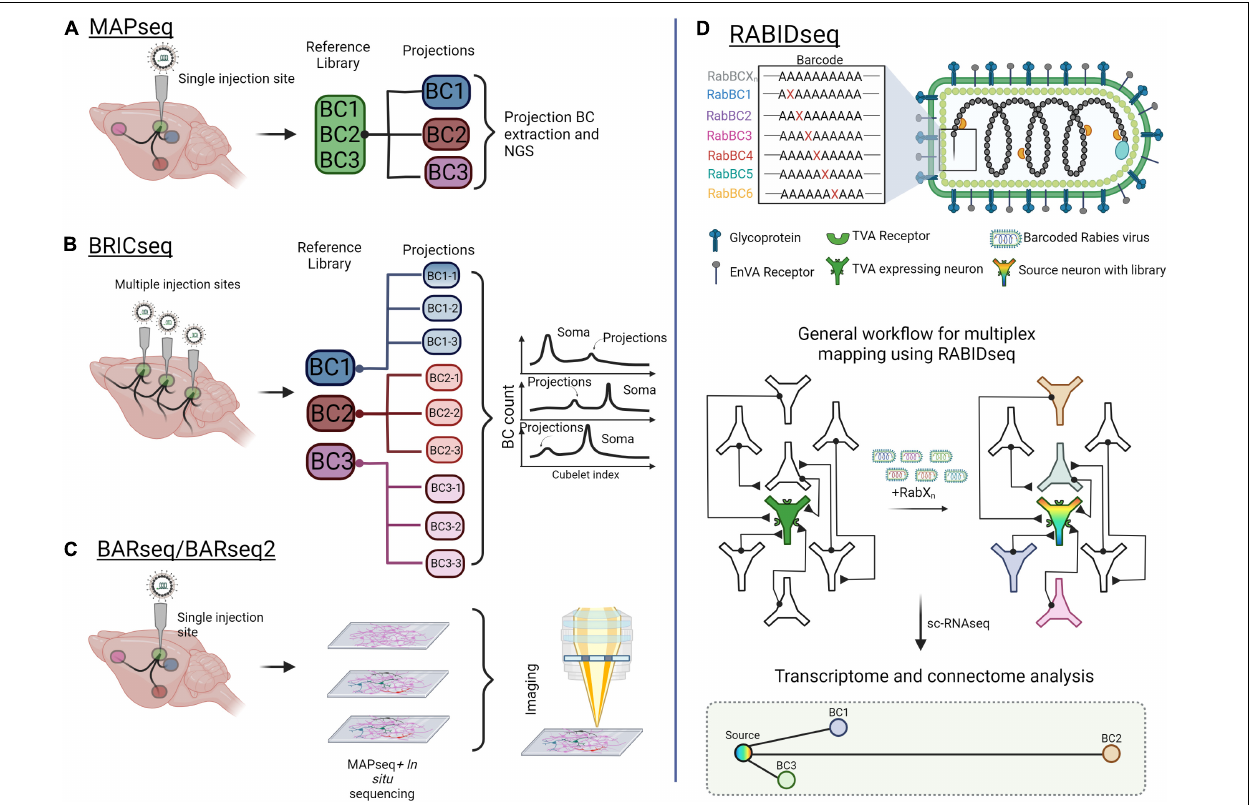
FIGURE 5 | Mapping brain-wide connections with multiplexed, barcoded viral tools. (A) Multiplexed Analysis of Projections by Sequencing (MAPseq) uses barcoded viruses to identify projections from a single injection site. Barcodes are extracted from the injection site and from axons at the projections. (B) Brain-wide individual animal connectome (BRICseq) uses the same barcoded viral library strategy as MAPseq but for multiple sites in the brain. Different “zipcodes” are designated to a spatial location within the brain and small dissections of tissue are removed for analysis. Soma and projections are then determined by the total makeup of barcodes in the projections compared to soma. (C) Barcoded anatomy resolved by sequencing (BARseq) is a technique that combines MAPseq and in situ sequencing to maintain the physical position of neurons and their axons within the brain. (D) Rabies barcode interaction detection followed by sequencing (RABIDseq) uses rabies virus and sequencing to gather transcriptome data on mono-transsynaptic partners. Created with